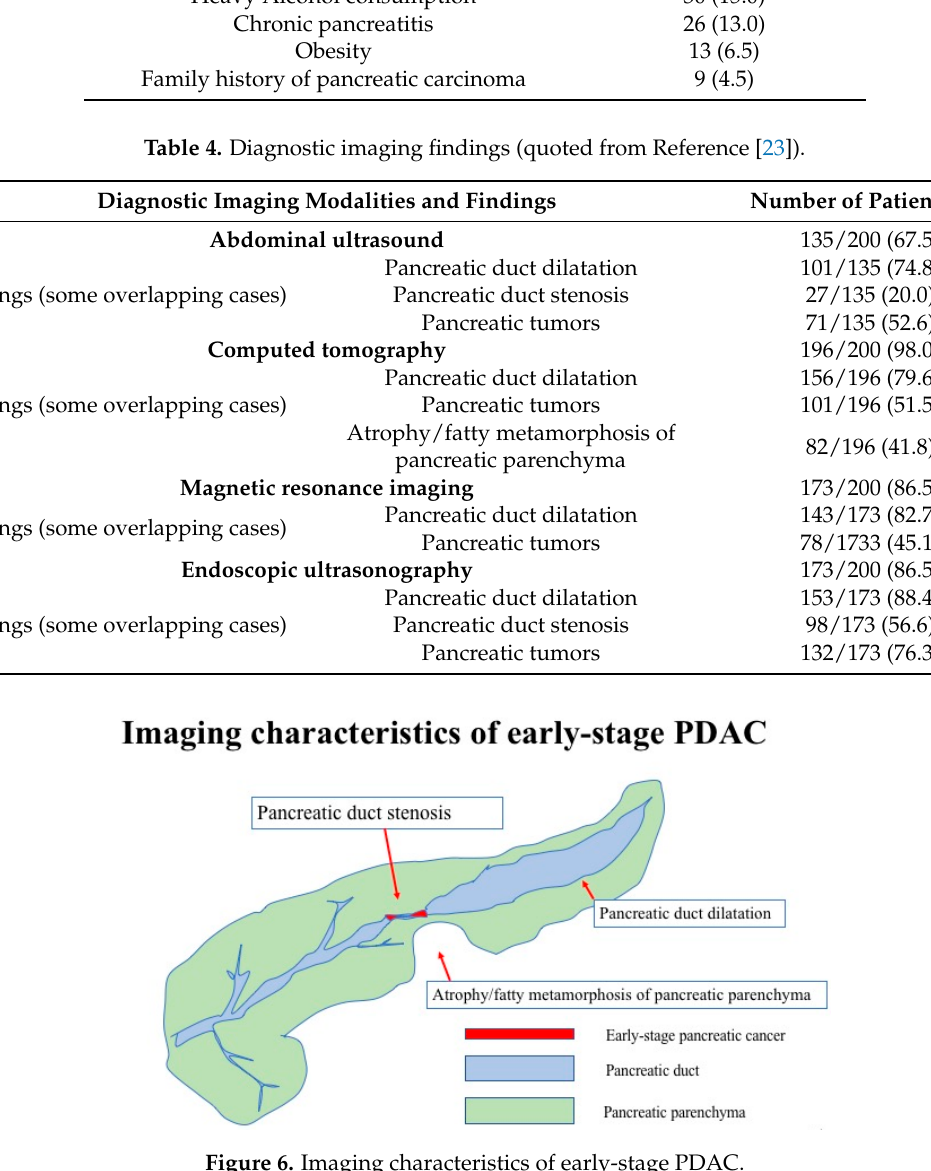
Figure 6. Imaging characteristics of early-stage PDAC.